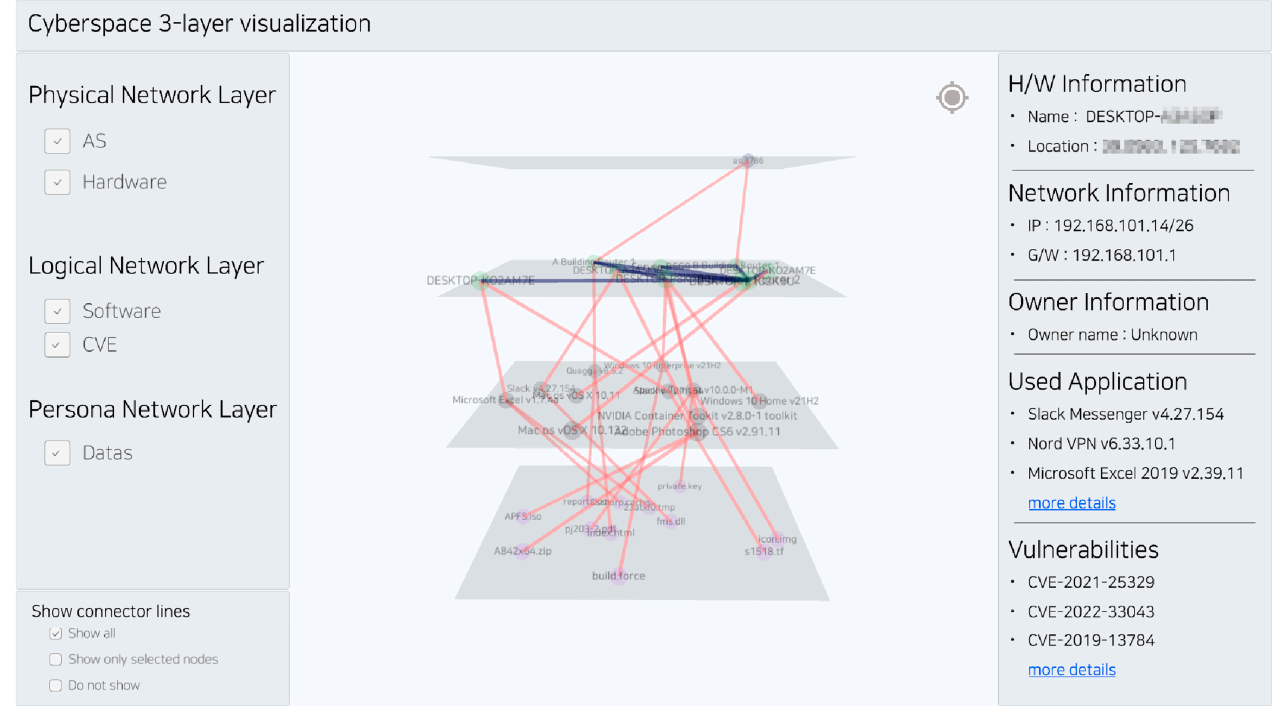
Figure 11. Visualization ⑤ : Visualize the Three Layers of Cyberspace.